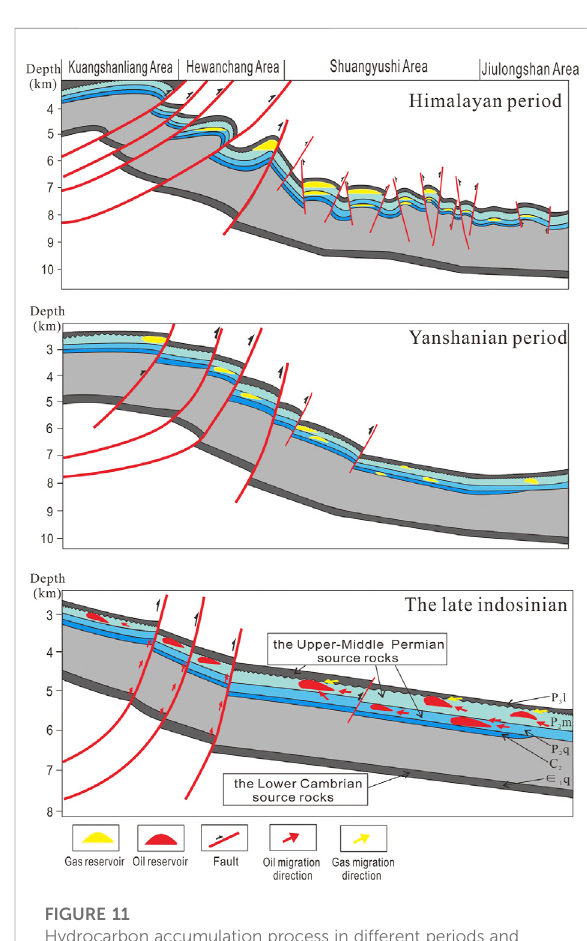
FIGURE 11 Hydrocarbon accumulation process in different periods and in different areas of the Northwestern Sichuan